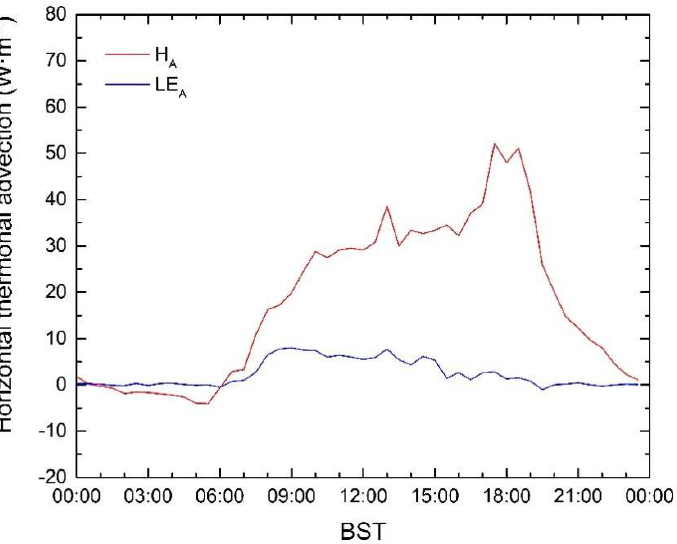
Figure 7. A diurnal ensemble average over 15 days for H A (red line) and LE A (blue line) in FOF from 11 July to 25 July 2017.